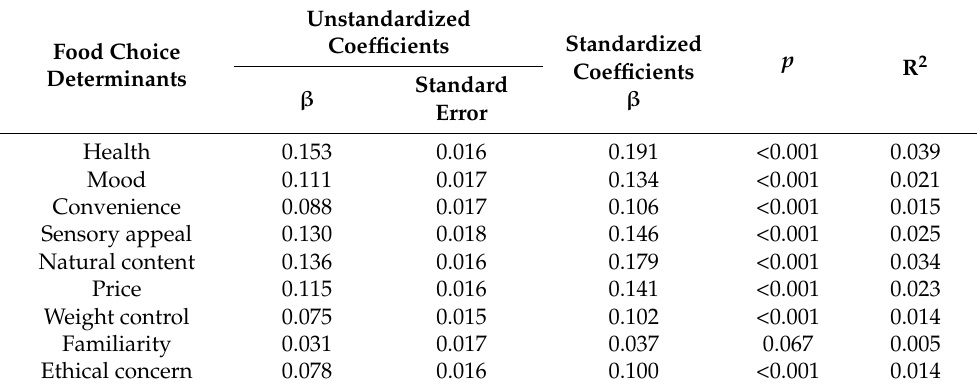
Table 3. Analysis of association between food choice determinants assessed by Food Choice Ques- tionnaire (FCQ) and vegetable preference assessed by Food Preference Questionnaire (FPQ) (model adjusted for sex and age) within the population of the second phase of the Polish Adolescents’ COVID-19 Experience (PLACE-19) Study ( n = 2415).